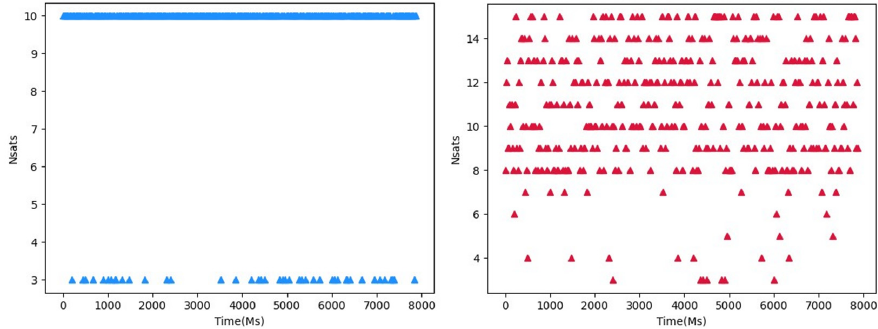
Figure 8. The change of “Number of Visible Satellites” before and after adding jitter.